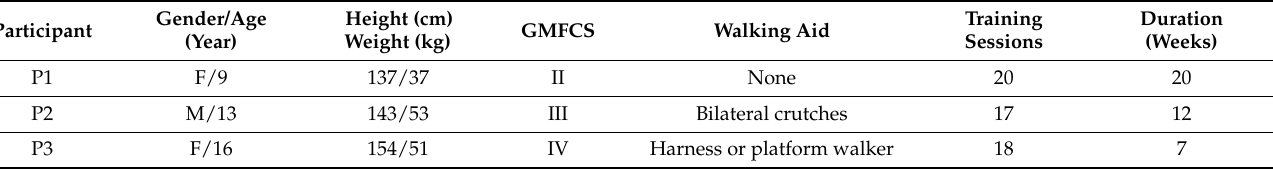
Table 1. Demographic data of the participants.